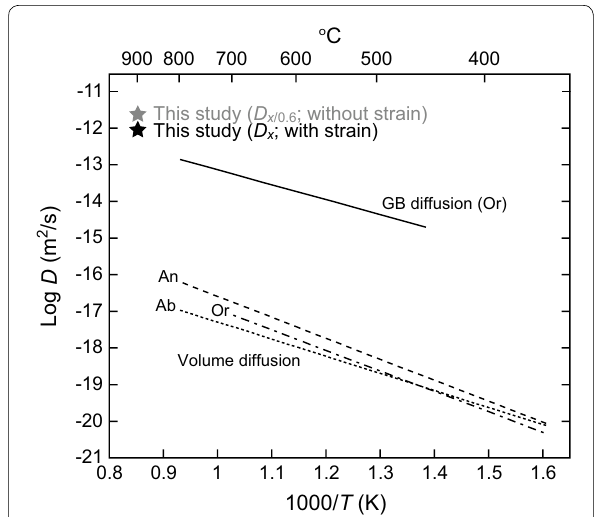
Fig. 12 Comparison of the diffusion coefficients of feldspar in an Arrhenius diagram. The values determined in this study with and without 40% strain are shown as black and gray stars, respectively. The values of the volume diffusion and grain boundary diffusion coefficients were taken from Giletti et al. (1978) and Farver and Yund (1995), respectively. An anorthite; Or orthoclase; Ab